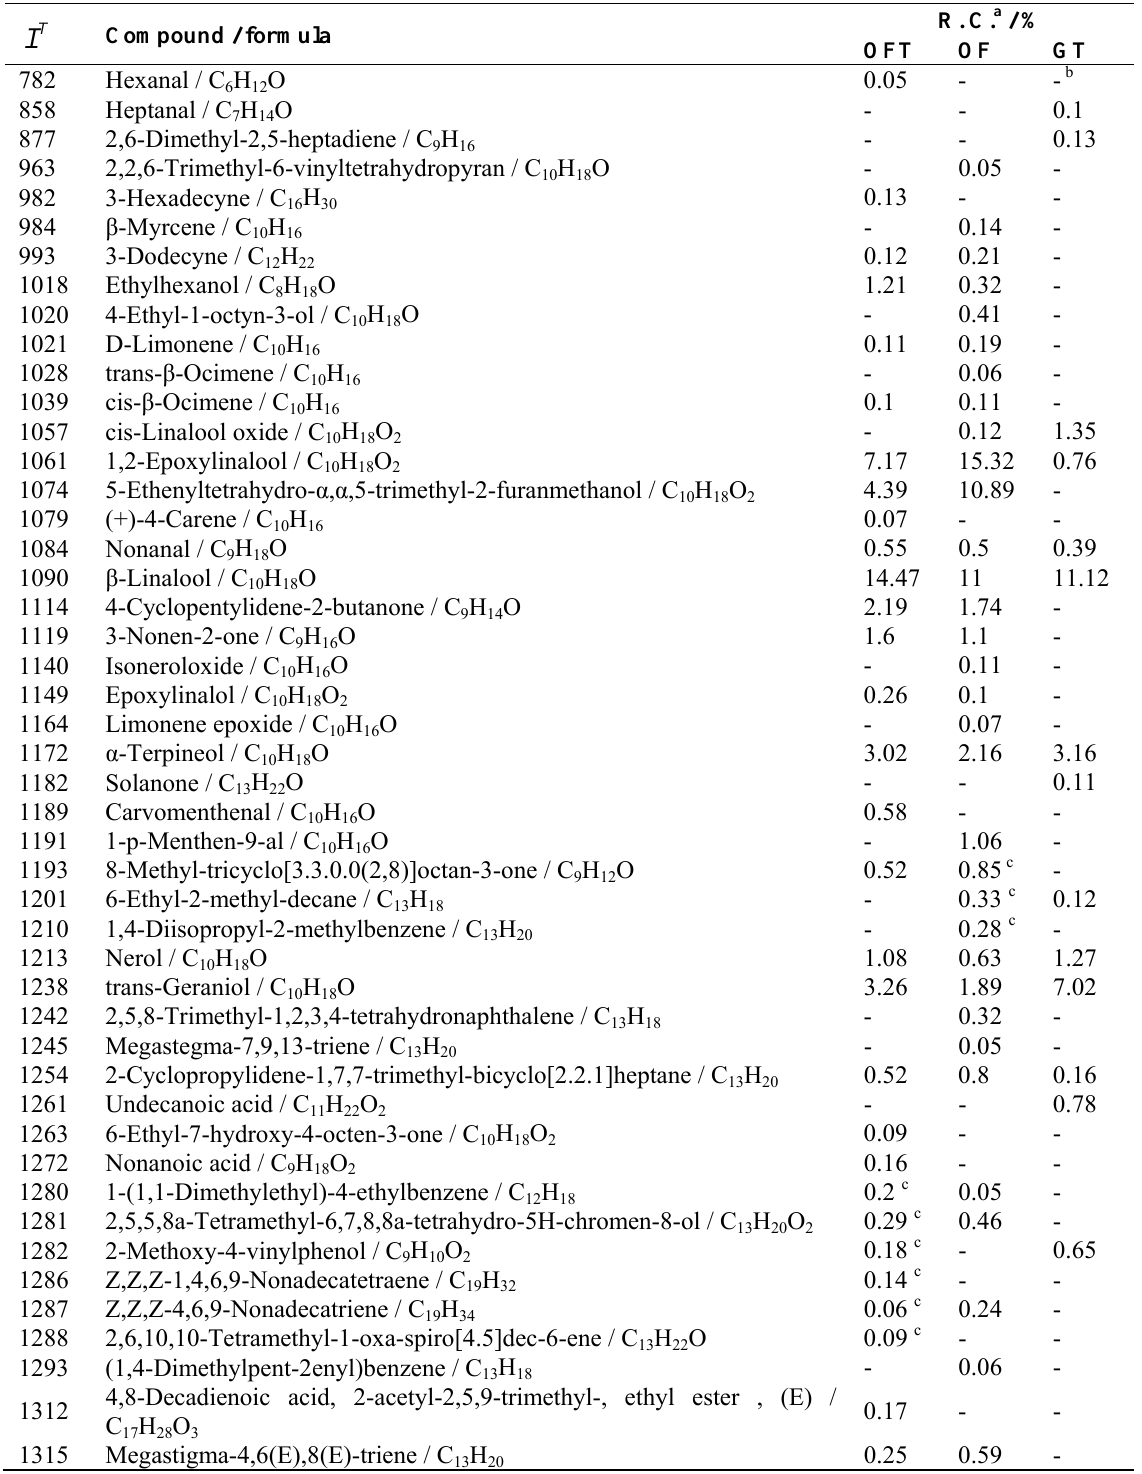
Table 1. Compositions of the essential oil from OFT, OF and